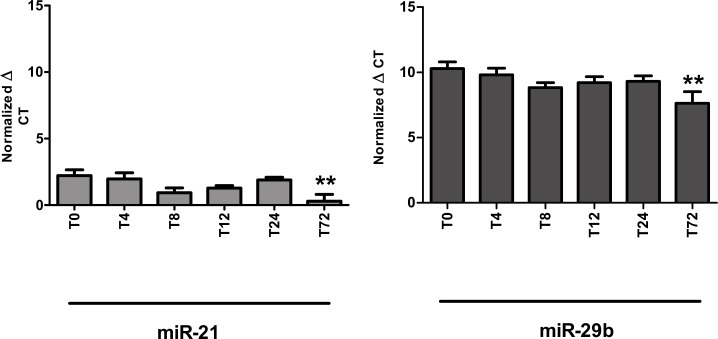
Stability of miRNA in whole blood incubated at room temperature.Whole blood was collected into EDTA containing tubes and incubated for 0, 4, 8, 12, 24 and 72 h at room temperature before processed into plasma. qRT-PCR was performed. Statistically significant differences in miRNA expression are marked with asterisks (**). **p<0.01. A) miR-21. B) miR-29b.